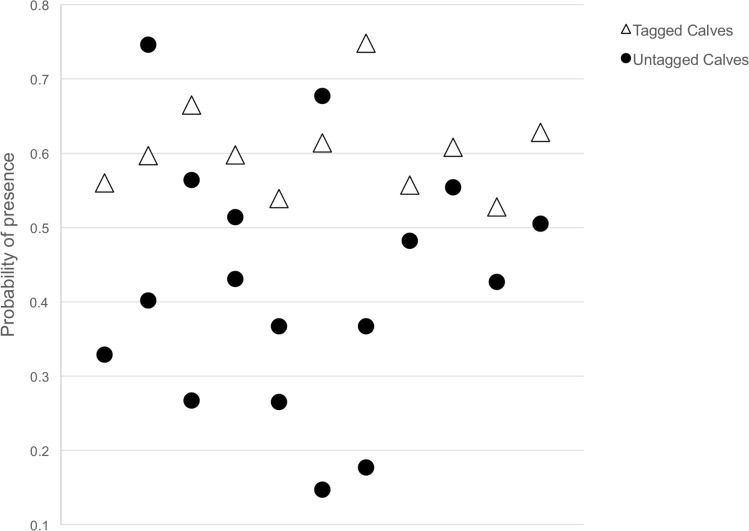
Probability of panther presence predicted by the panther hunting habitat model at locations of tagged and untagged calf depredations documented in southwest Florida.Points are arbitrarily distributed along the x-axis for illustrative purposes (to prevent overlapping points) and do not reflect a time series.